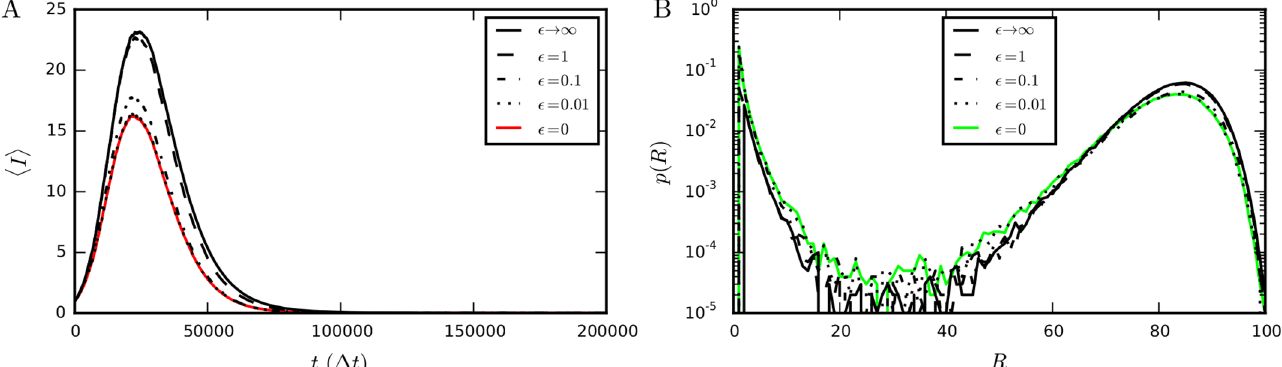
Fig 7. Comparison of the outcome of non-Markovian SIR processes for different values of the parameter (cid:2) . (A) Average number of infected nodes, h I i , as function of time for a SIR process with Weibull distributed recovery times. (B) Distribution of the numbers of recovered nodes after the infection has died out (i.e. when I = 0). For (cid:2) = 0 the temporal Gillespie algorithm is quasi-exact (see S3 Fig for comparison with rejection sampling); for (cid:2) ! 1 , corresponding to a first-order cumulant expansion of L ð t ; F t Þ around t = t * (see main text), it is least accurate. As (cid:2) is decreased, both h I i ( t ) and p ( R ) rapidly approach the quasi-exact result obtained for (cid:2) = 0. Simulations were performed on an activity-driven network consisting of N = 100 nodes with activities a i = z i /10, where − 4 Hz; the length of a time-step was Δ t = 1 s and the infection rate β = 100 μ z z (cid:5) 3 : 2 ’ recovery times followed Eq (23) with γ = 1.5 and μ 0 = 10 i (cid:4) i ; nodes Hz.